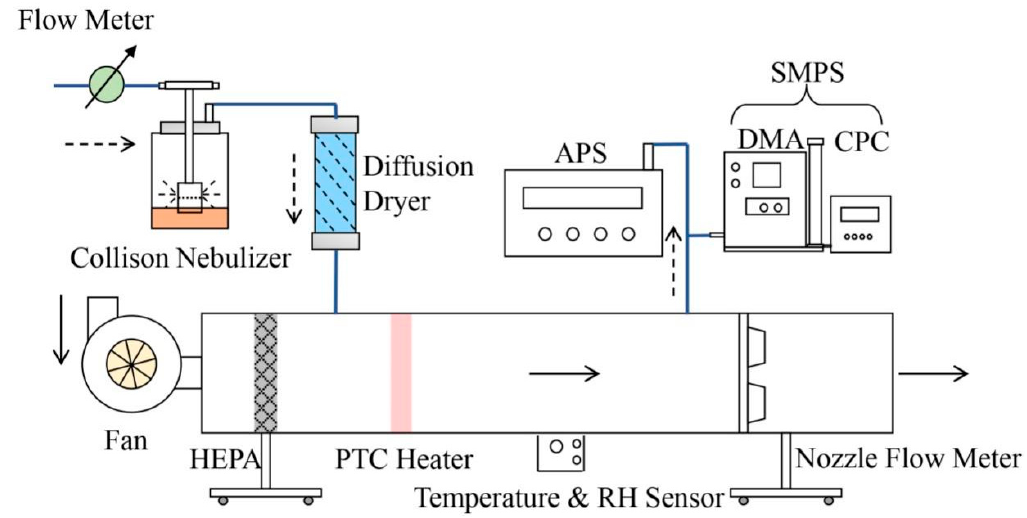
Figure 1. Schematic diagram of experimental setup.